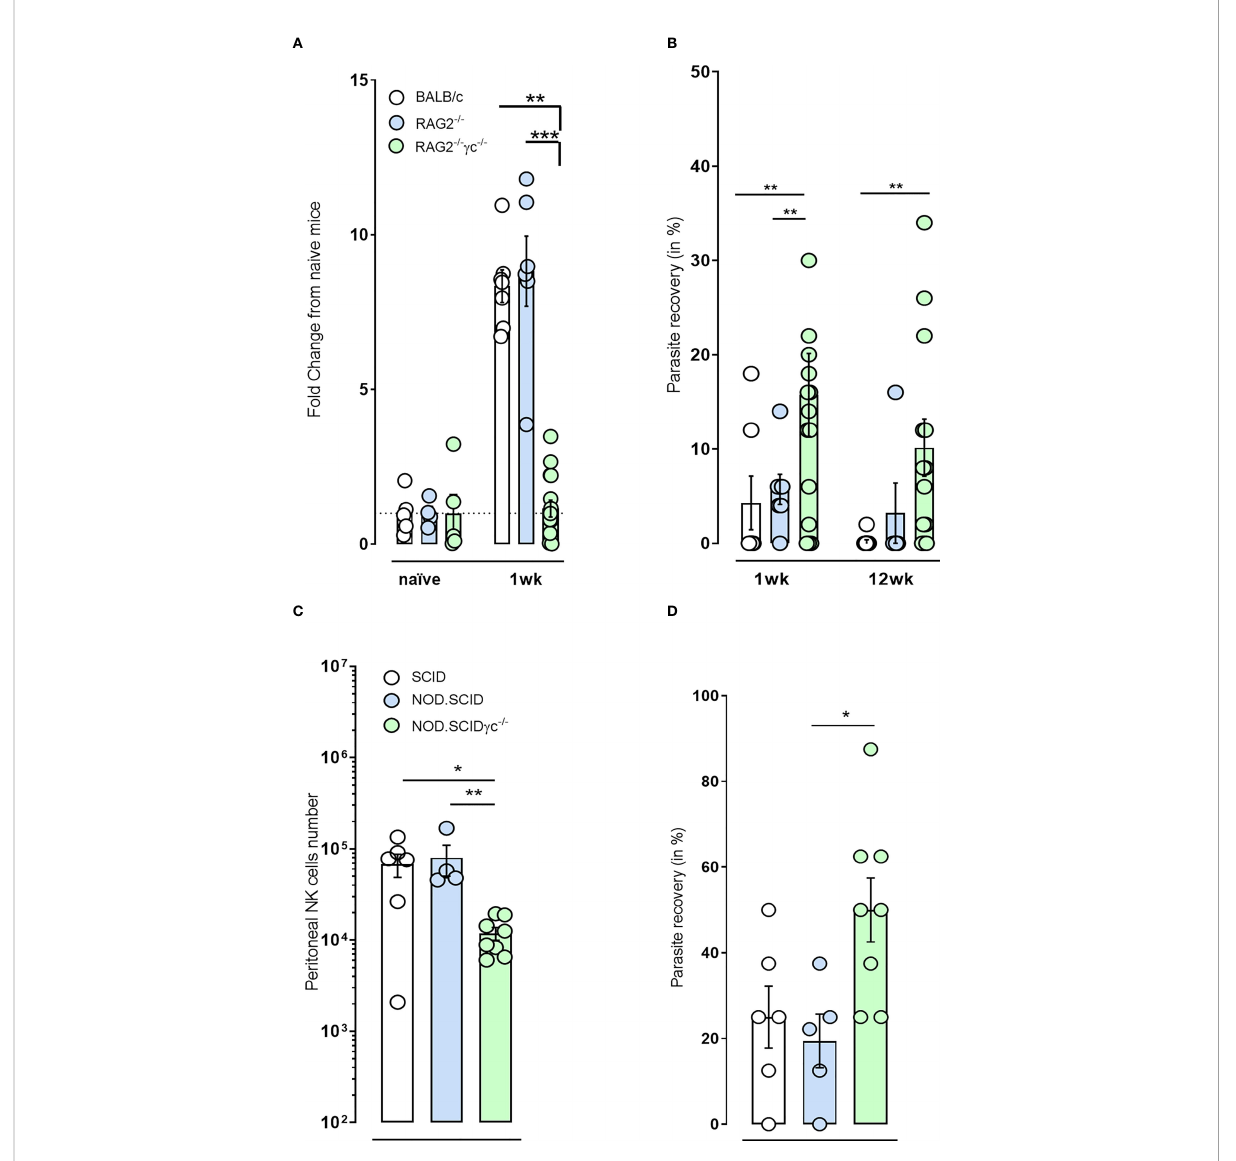
FIGURE 2 NKp46 + NK cell impairment in immunode fi cient mice via g c de fi ciency renders mice more susceptible to B. malayi and Onchocerca ochengi infection. (A) Temporal changes in NKp46 + NK cell populations at the site of infection or (B) Parasite recovery in infected BALB/c immunocompetent, RAG2 -/- and RAG2 -/- g c -/- immunode fi cient mice at either 1 or 12 weeks post- B. malayi infection. (C) NKp46 + NK cell numbers at the site of infection and (D) Parasite recovery in infected SCID, NOD.SCID and NOD.SCID g -/- immunode fi cient mice 6 weeks post- O. ochengi worm infection. Statistical signi fi cance is derived from a Kruskal-Wallis test followed by Dunn ’ s multiple comparisons tests, n=5-16, two pooled experiments (B. malayi , 1wpi repeated) n=4-8, single experiment (O. ochengi ). Signi fi cance is given as: *:p < 0.05, **:p < 0.01, ***:p <